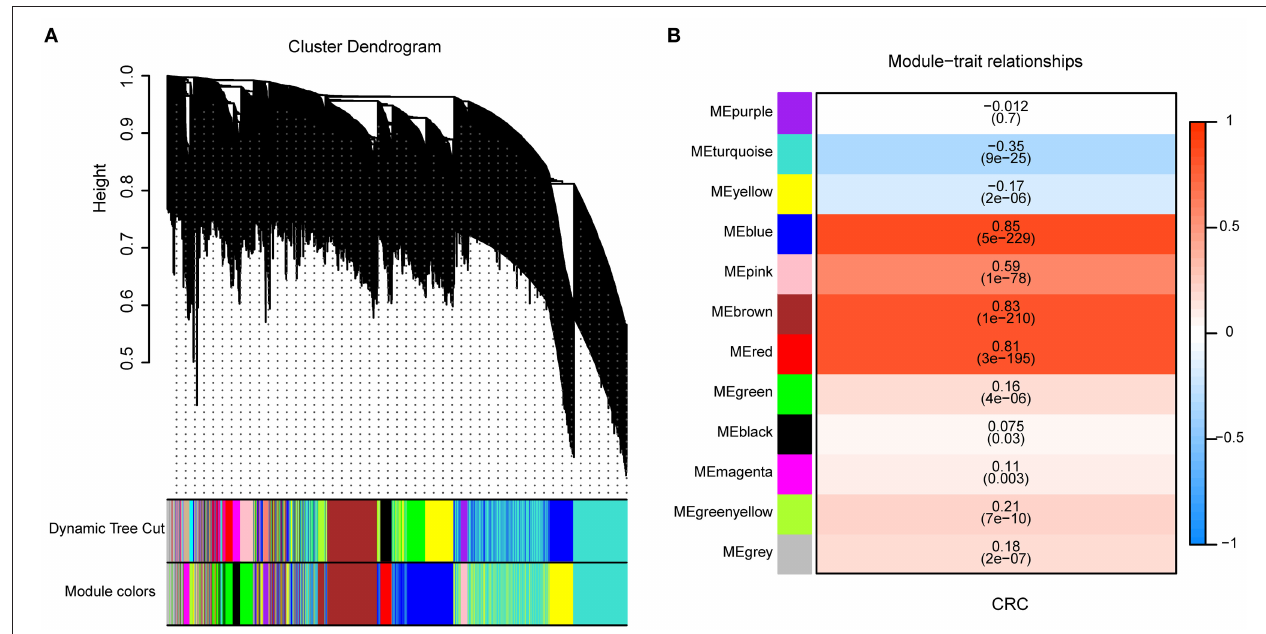
FIGURE 2 | Identification of genes associated with Colorectal cancer (CRC) by Weighted Correlation Network Analysis (WGCNA). (A) Clustering dendrogram of 6,442 genes and 12 merged modules from 820 samples. (B) Correlation between modules and CRC scores. The upper row in each cell indicates the correlation coefficient ranging from – 1 to 1 of the correlation between a certain module and CRC. The lower row in each cell indicates the p -value.